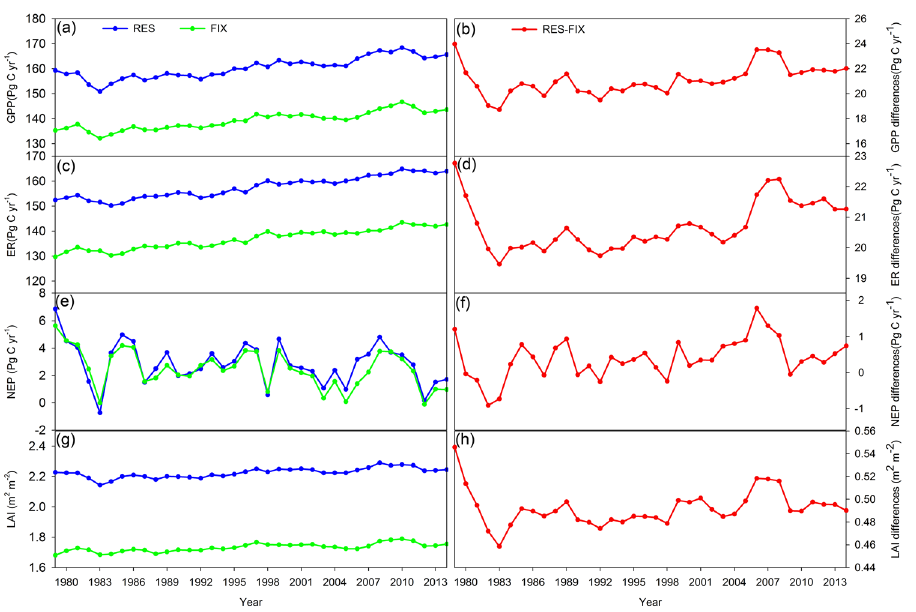
Figure 3. Estimated gross primary production (GPP), ecosystem respiration (ER), net ecosystem productivity (NEP), and leaf area index (LAI) from 1979 to 2014. RES and FIX refer to the four variables from CABLE with resource limitation and fixed coefficient carbon allocation models, respectively. RES–FIX refers to their